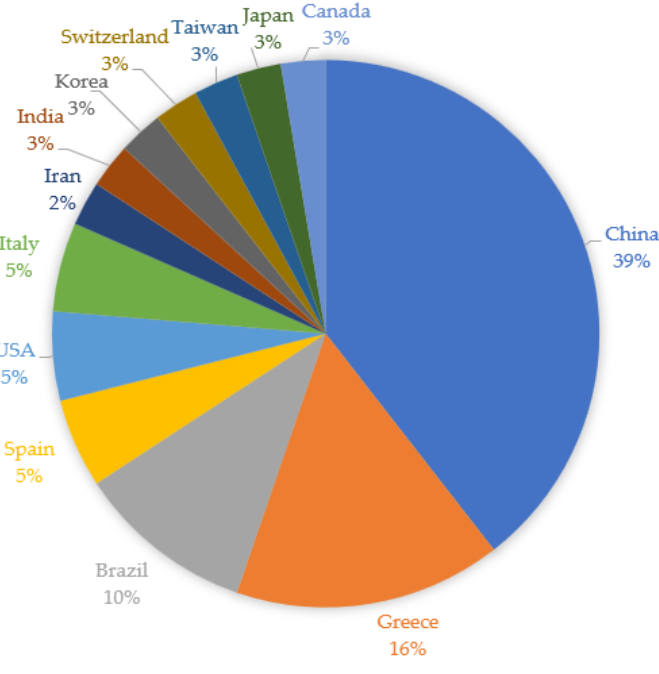
Figure 2. Countries where the selected studies were conducted.